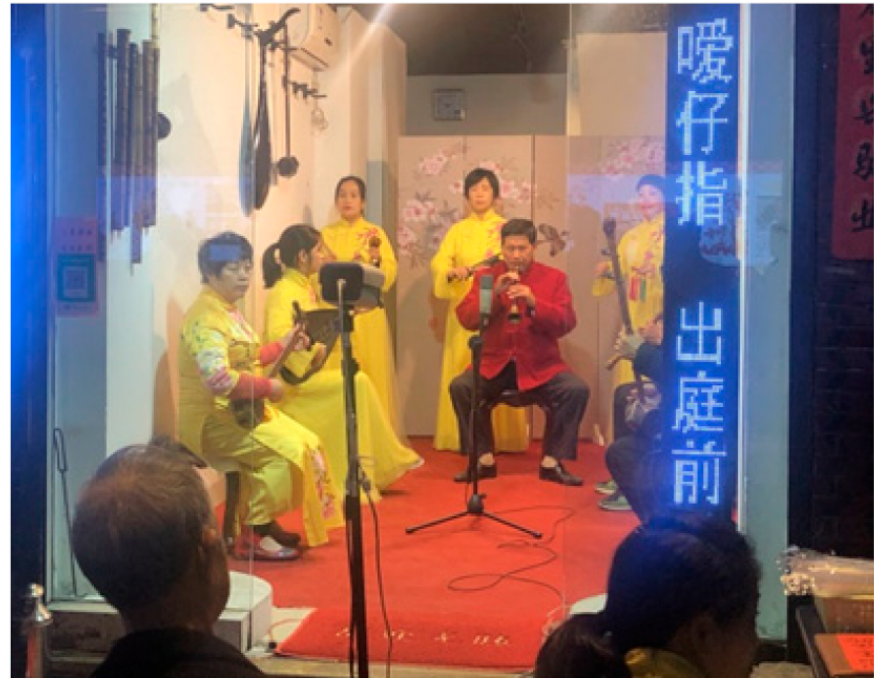
Figure 1. The exhibition and performance of “Nanyin”—the intangible cultural heritage of “Pu Jing” Cuo Cheng space. (Note: Nanyin is a type of ancient Chinese music with typical culture of Minnan area, as a song of Quanzhou